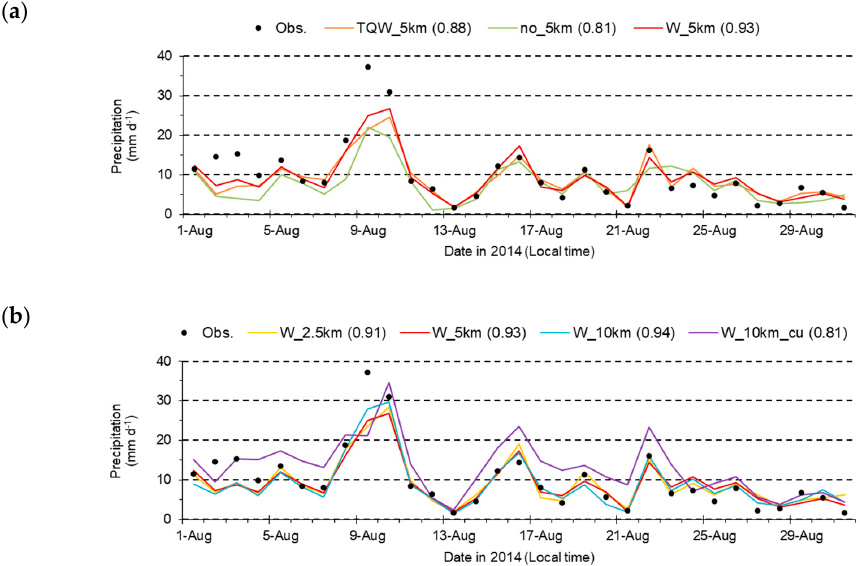
Figure 3. Mean daily precipitations averaged for the meteorological observatories in each region during ( a ) 1 to 15 and ( b ) 16 to 31 August 2014 for the observation and six WRF settings. From these results, we decided to conduct the SST change experiment under the optimal setting with the nudging only for horizontal wind components, as well as the horizontal resolution of 5 km and without the cumulus scheme, namely W_5km case. The horizontal resolution of around 5 km has been widely used in previous studies [11,18,24,31,56]. The W_5km case captured the amount of precipitation in the extreme heavy rainfall due to typhoons in the Shikoku region being the best